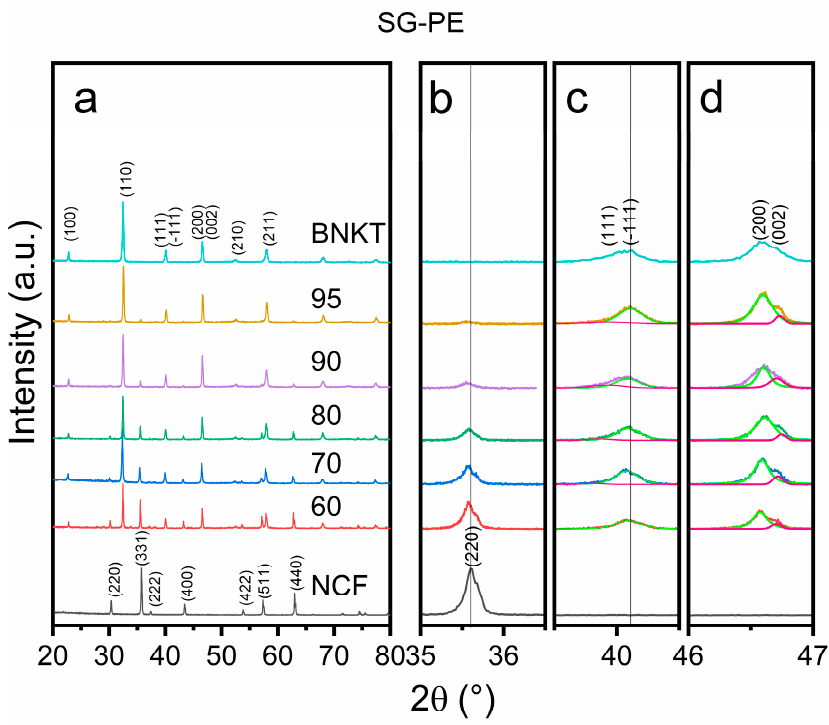
Figure 2. XRD patterns of the xBNKT-(100-x)NCF (x = 100, 95, 90, 80, 70, 60, 0) SG-PE composites ( a ) Enlargements of 35–36.5° ( b ), 39–41° ( c ), and 46–47° ( d ) angles.